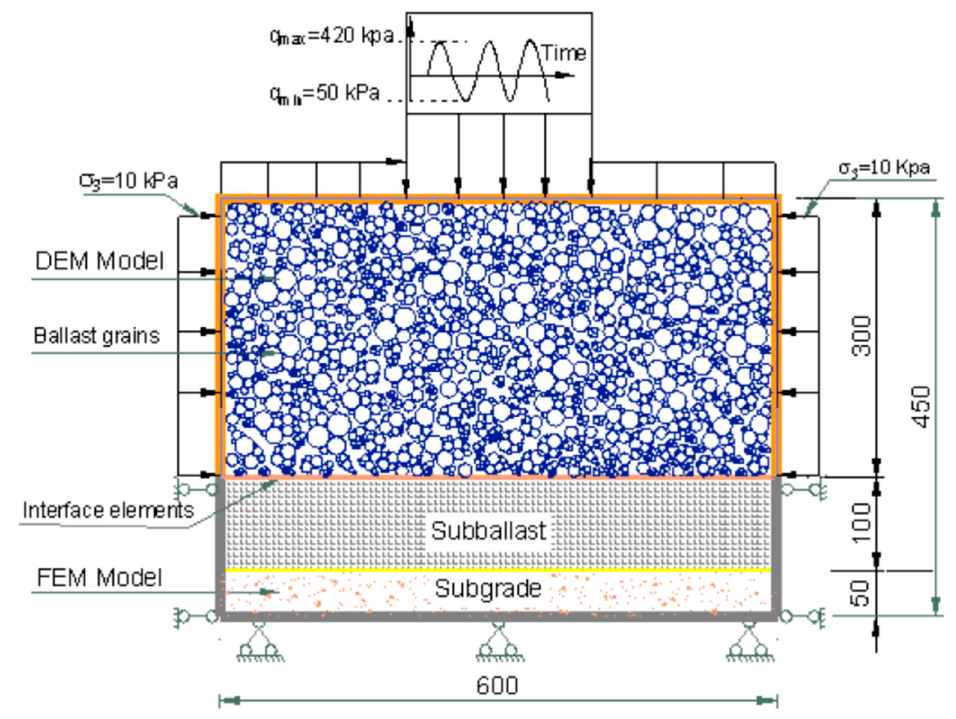
Figure 16. Coupled DEM-FEM to simulate the RPSTA tests for ballast (Ngo et al. [60]-with permission from ASCE).